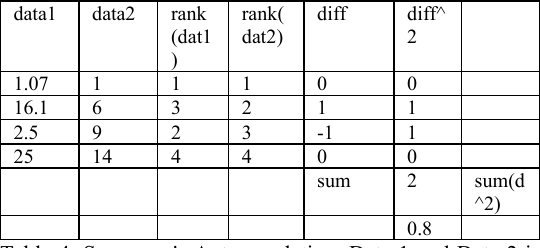
Table 4: Spearman's Autocorrelation. Data 1 and Data 2 is presented in mg/pixel The overall coefficient was 0.8 which means the two maps were highly correlated.